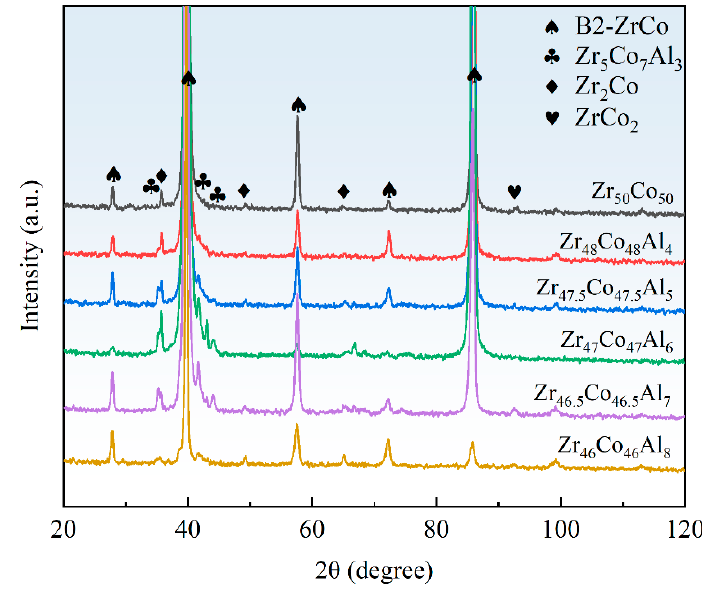
Figure 3. XRD patterns of Zr 50 − x/2 Co 50 − x/2 Al x (x = 0, 4, 5, 6, 7, 8) alloys.